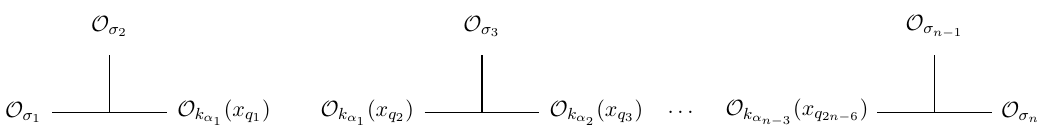
( x ) . σ i ≡ O σ i a i